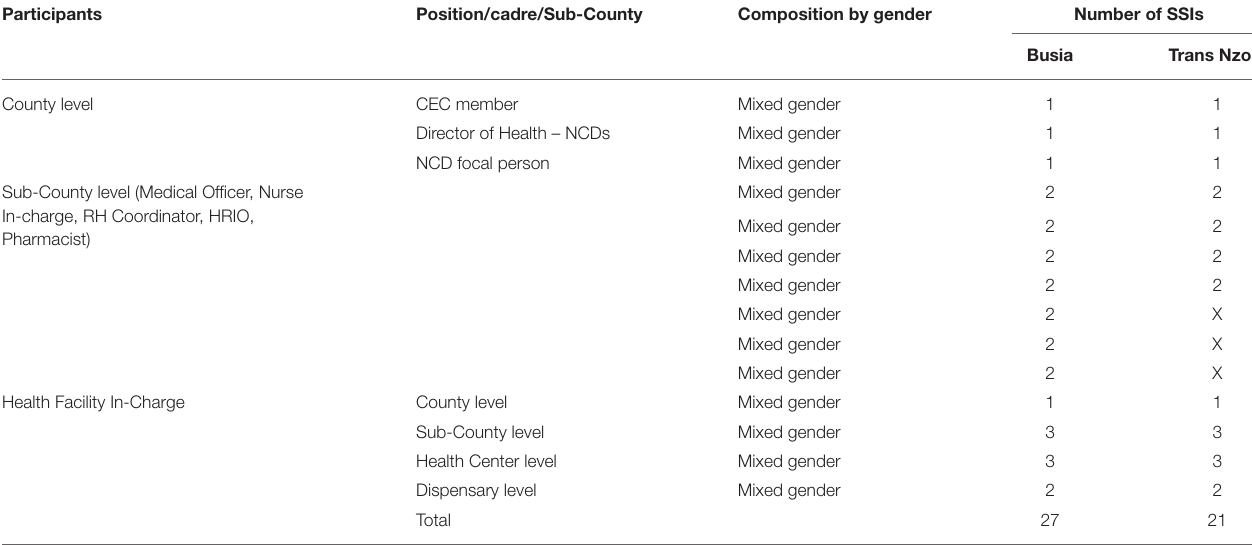
TABLE 1 | Recruitment for Semi Structured Interviews (SSIs).